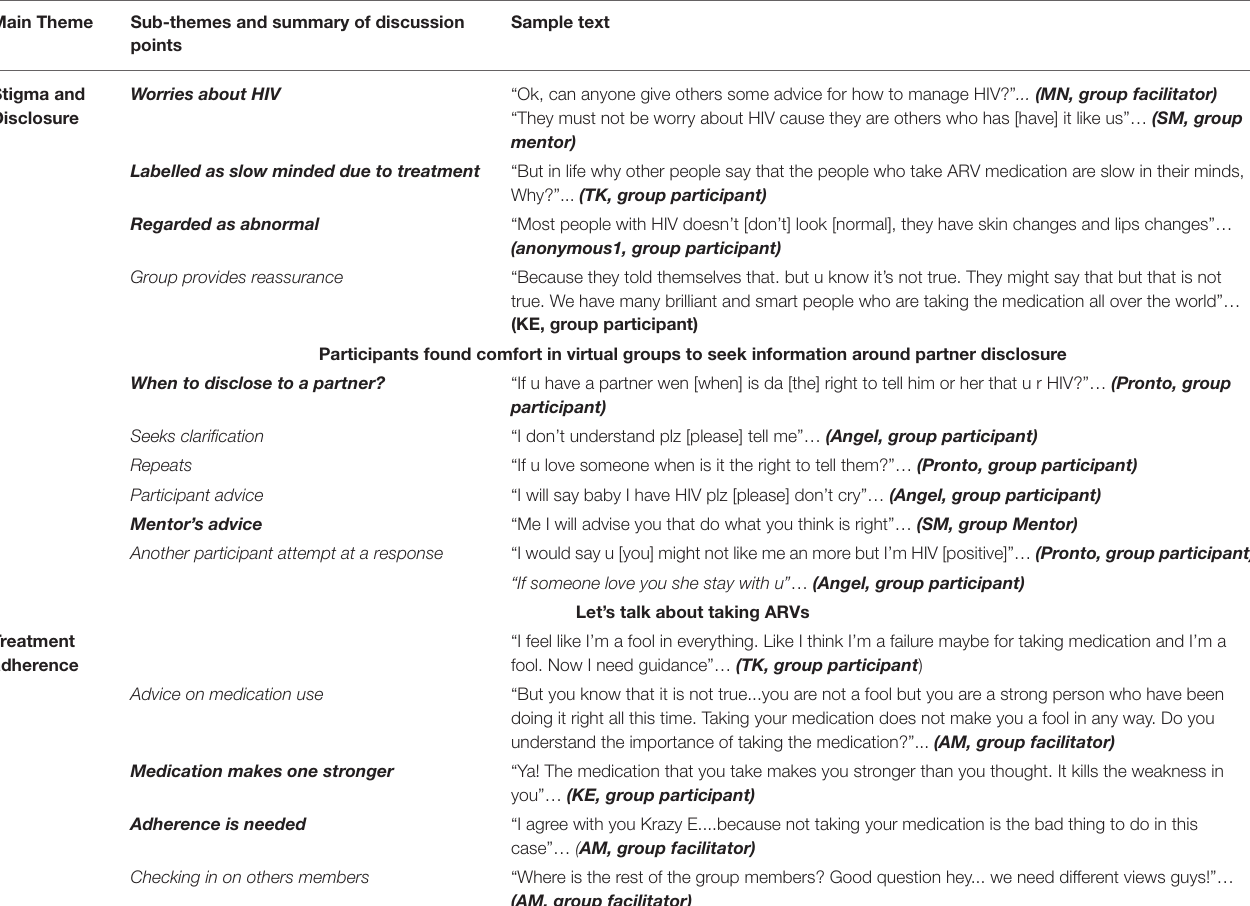
TABLE 3 | Text conversations on stigma, disclosure, and treatment